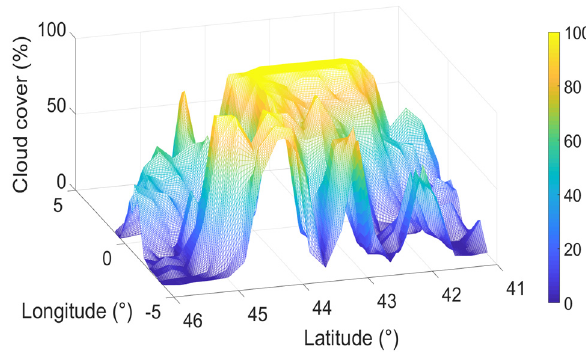
Figure 10. Geographical interpolation of the cloud cover: Result of the linear interpolation.